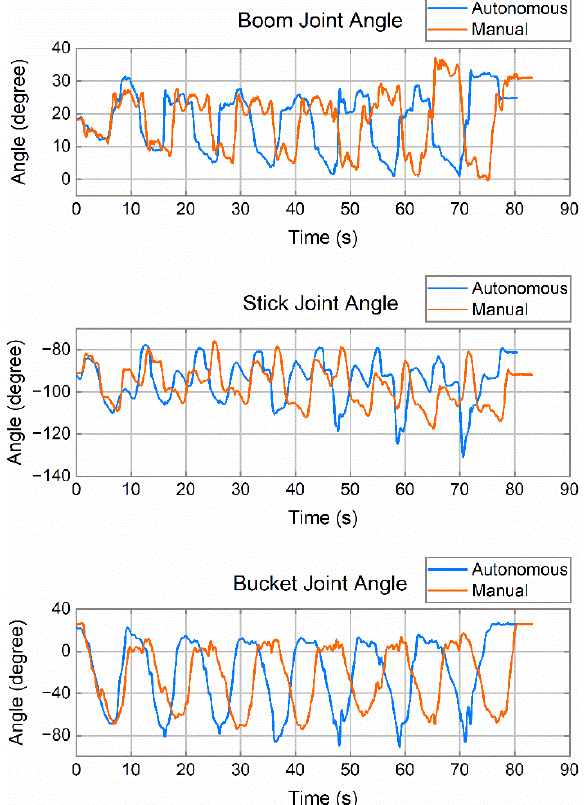
Figure 8. A comparison of joint trajectory between autonomous and manual excavation. The blue curve is autonomous excavation and the red curve is manual excavation.